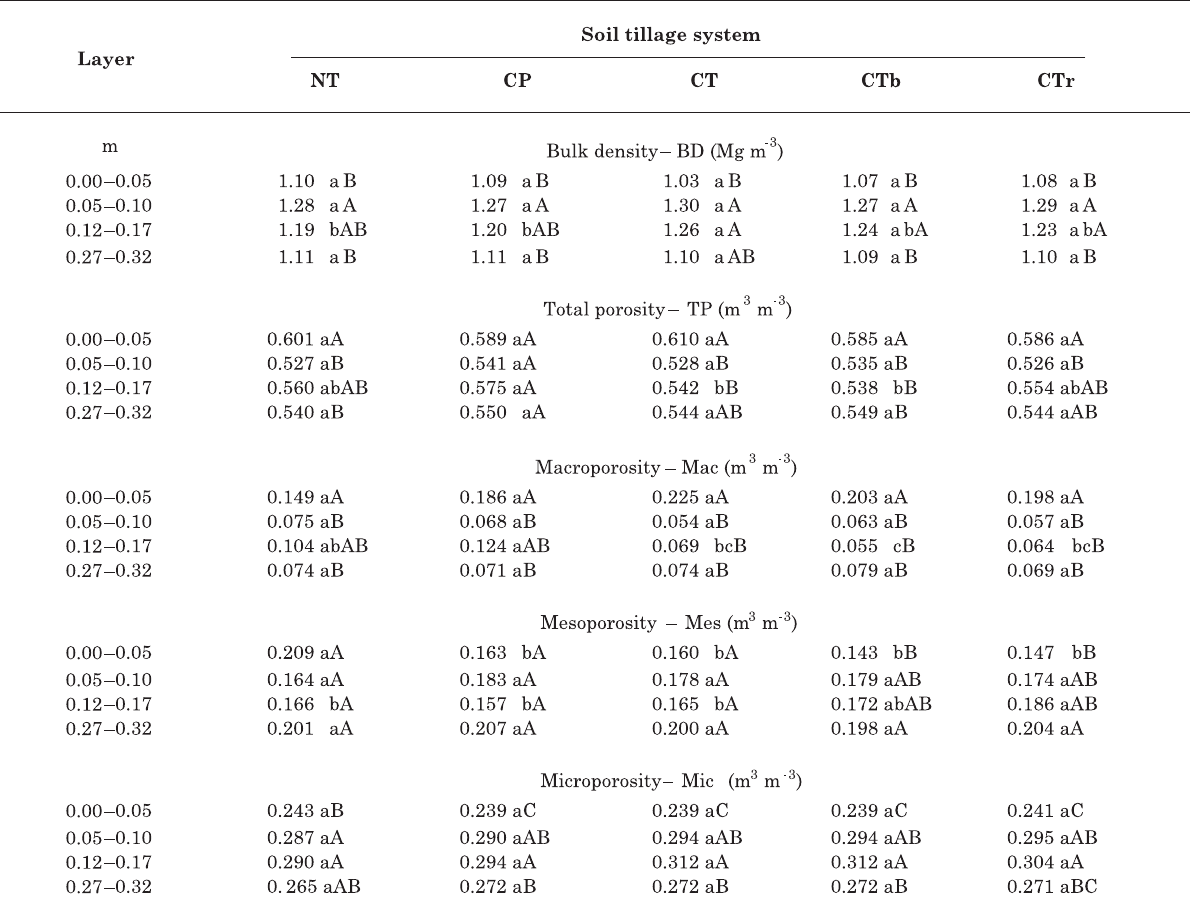
Table 1. Physical properties determined in four layers after nine years of applying five soil tillage systems (averaged across five nutrient